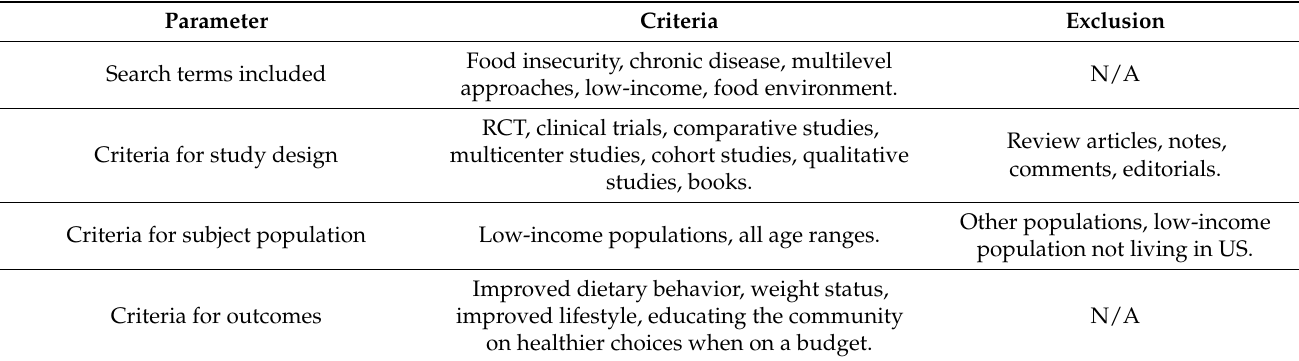
Table 1. Criteria for studies